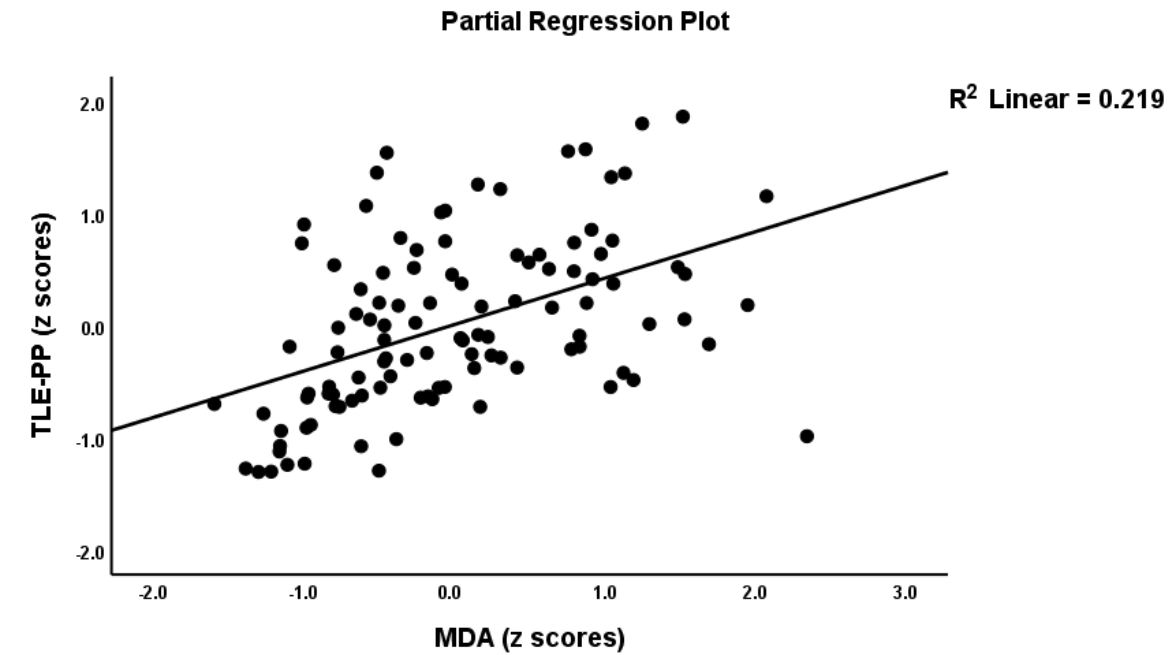
Figure 3. Partial regression of the temporal lobe epilepsy—psychopathology phenome score on malondialdehyde (MDA).